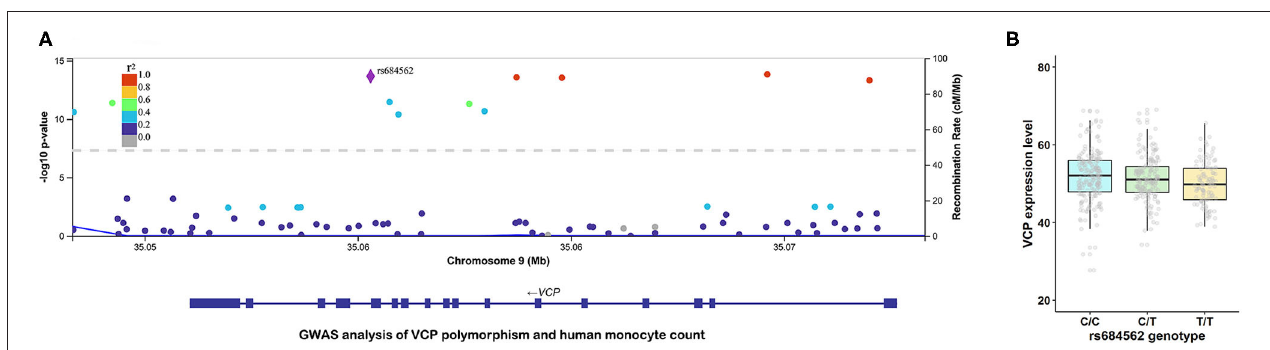
FIGURE 2 | VCP polymorphism is correlated with human monocyte count and VCP mRNA expression level. (A) Association between rs684562 and human monocyte count revealed by GWAS ( P = 2.20E-14). (B) Association between VCP mRNA expression level and the genotype of rs684562 revealed by eQTL analysis.